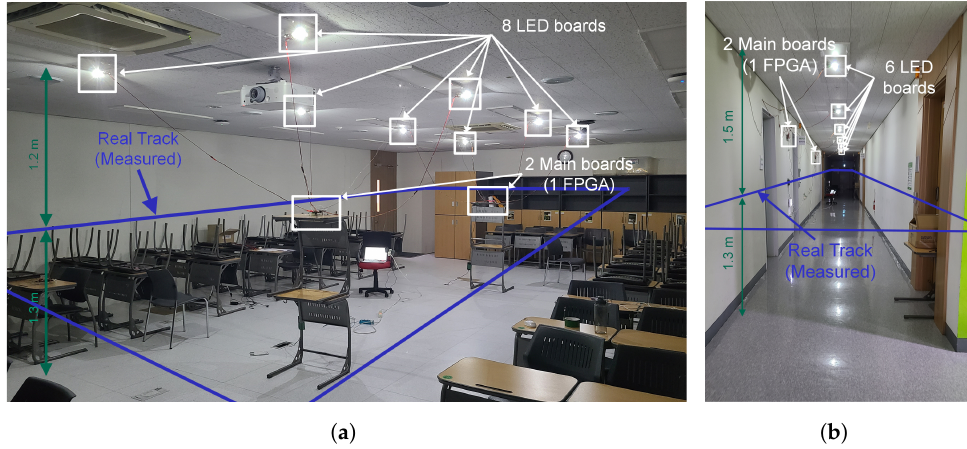
Figure 9. Experimental environment: ( a ) classroom (eight LEDs) and ( b ) corridor (six LEDs).